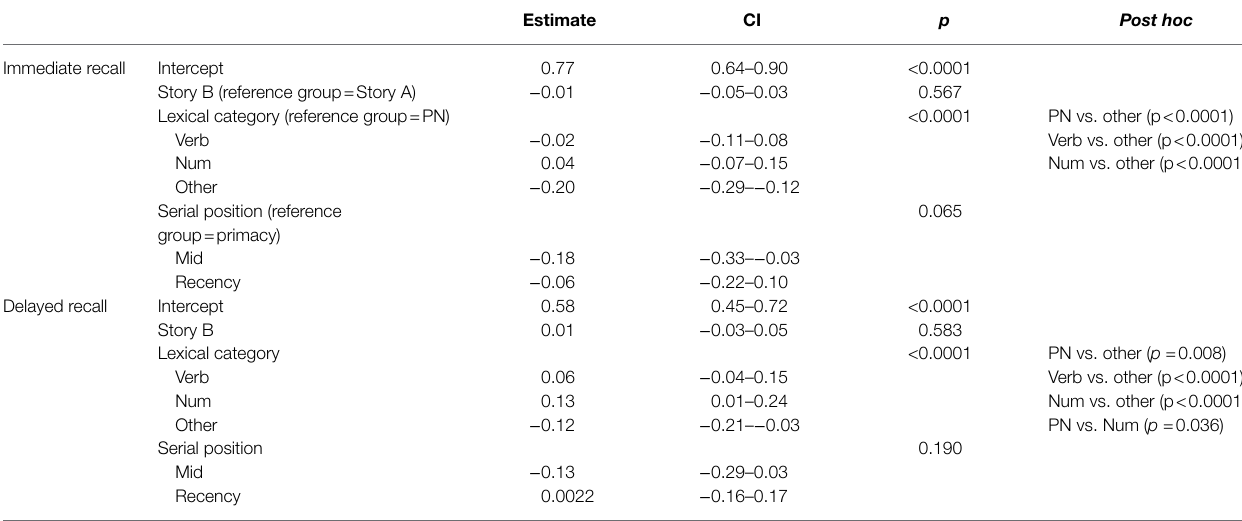
TABLE 2 | GLMM with the difficulty indices for immediate recall and delayed recall predicted by story, lexical category, and serial position. Estimate CI p Post hoc